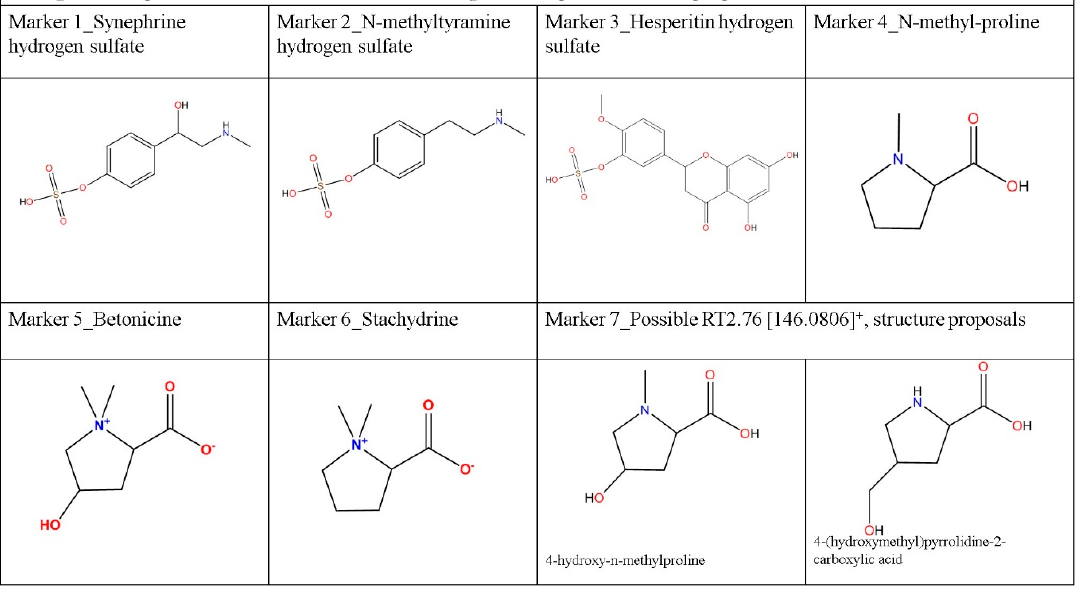
Figure 4. Tentative structures and identity of the makers elucidated.